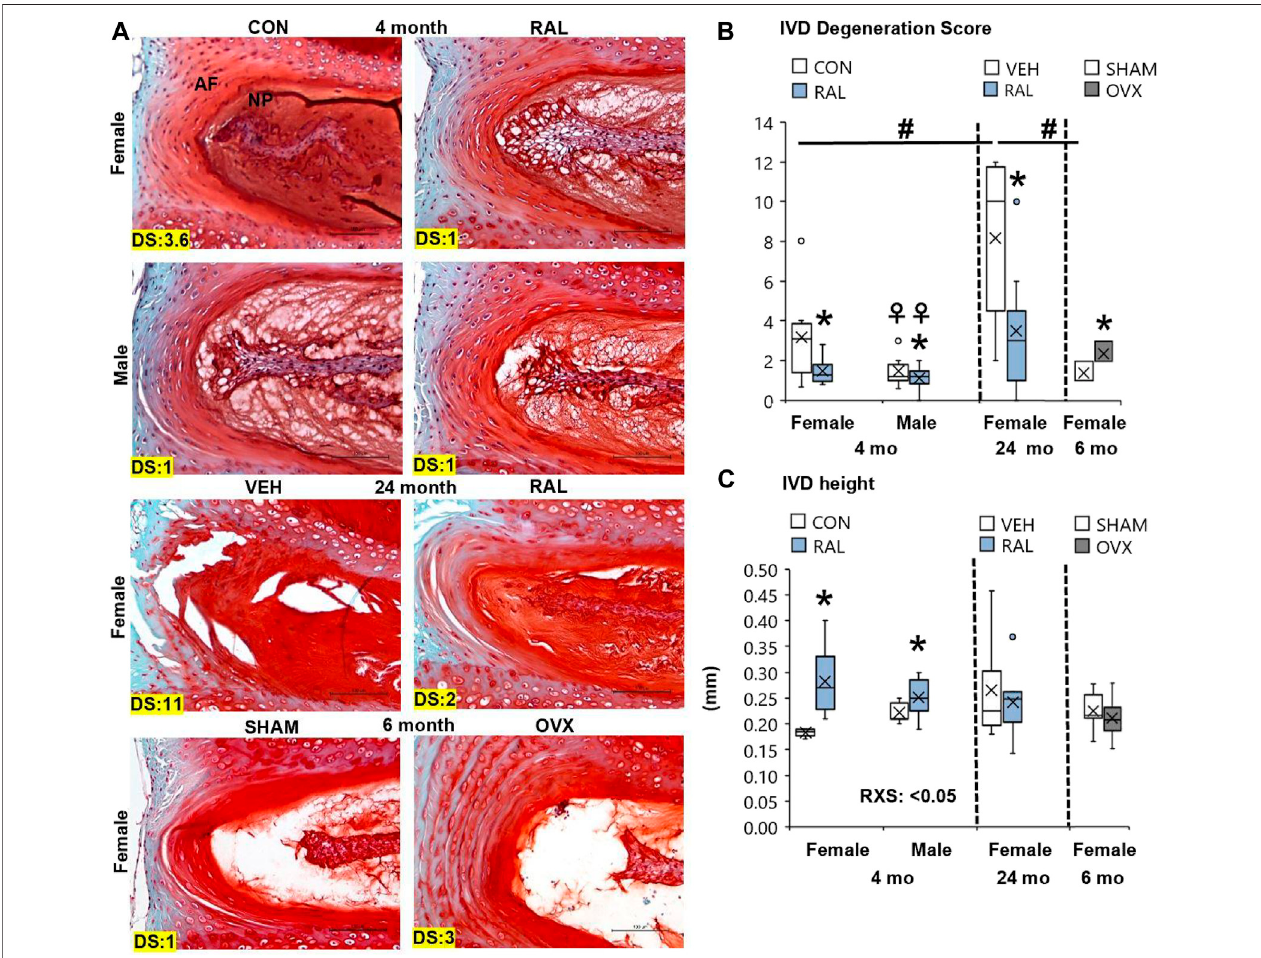
FIGURE2 | Raloxifene improved lumbarIVD degeneration scoreand IVDmorphology. (A) 20xSafranin-O/Fast Green stainingofIVD with diskdegeneration score (DS)ofeachrepresentativeimagesbottomleftcorner. (B) IVDdegenerationscore, (C) IVDheightofyoung-adult(4 months),old(24 months),andOVX(6 months)mice. Data are represented as box plots with mean marked as cross (x), 25/75% deviation lines, and maximum/minimum whiskers. *: Control (CON, n = 5/sex/group) vs. raloxifene(RAL);R:CONvs.RAL;S:malevs.female;RxS:interaction;vehicle(VEH, n =8/group)vs.RAL,SHAM( n =4 – 5/group)vs.ovariectomized(OVX); # :aging effect (4 months vs. 6 months vs. 24 months); \ : sex effect (male vs. female), p < 0.05. Scale: 100 μ